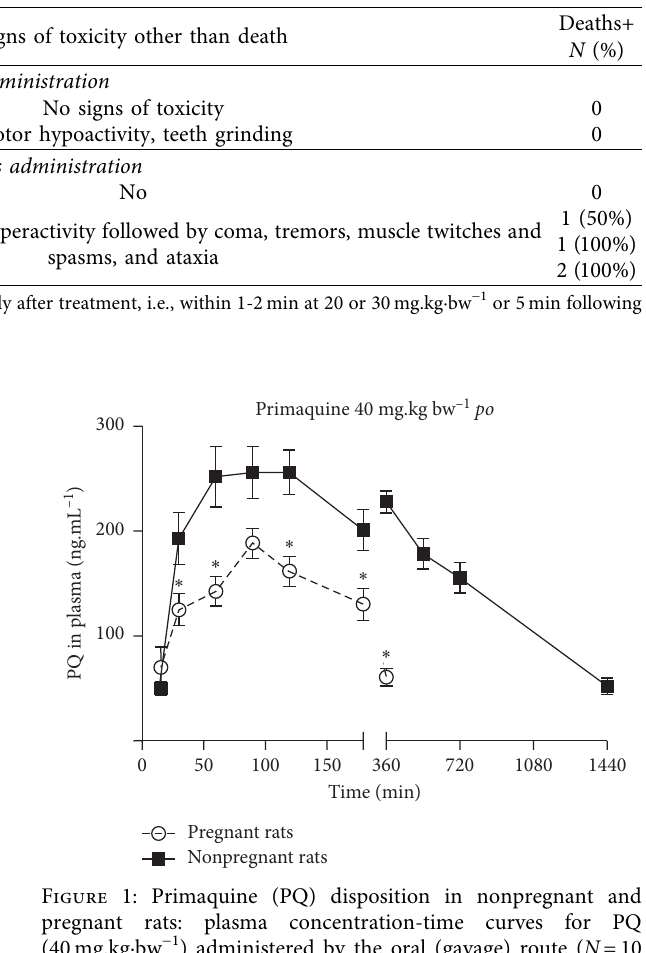
Table 1: Signs of toxicity noted in female rats treated with a single oral or intravenous dose of primaquine (PQ) and observed for 24h after treatment.